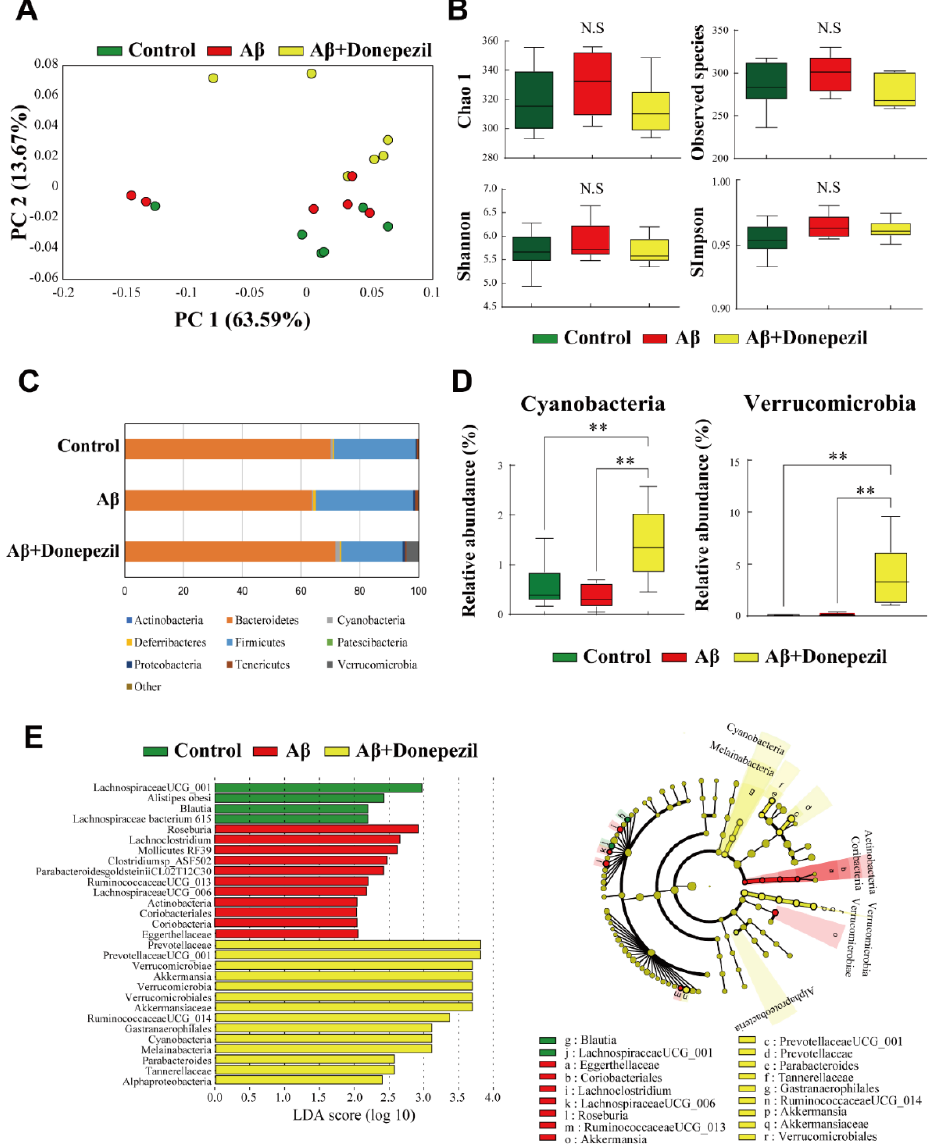
Figure 2. ( A ) Beta diversity analysis of the control, Aβ, and Aβ + donepezil groups based on weighted UniFrac distance matrices. ( B ) Alpha diversity analysis of the control, Aβ, and Aβ + donepezil groups. ( C ) Comparison of microbiota composition at the phylum level. ( D ) Relative abundance of cyanobacteria and Verrucomicrobia. ( E ) Linear discriminant analysis (LDA) and the cladogram show the phylogenetic distribution of microbes that are associated with the control, A β , and A β + donepezil groups. Taxonomic levels of the phylum, class, and order are labeled, while family and genus are abbreviated. Plots are represented using LDA effect size (LEfSe). **, p <